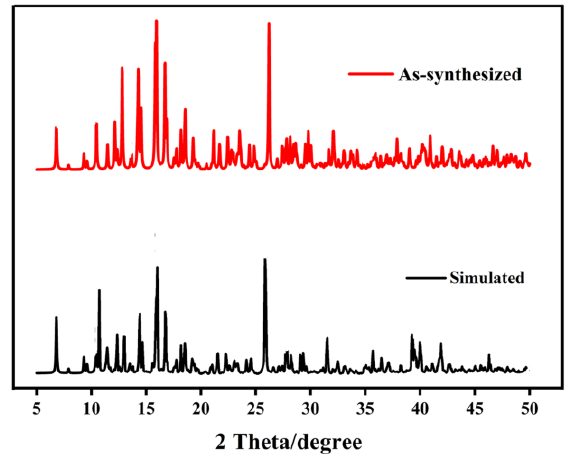
Figure 7. PXRD of complex 1 .